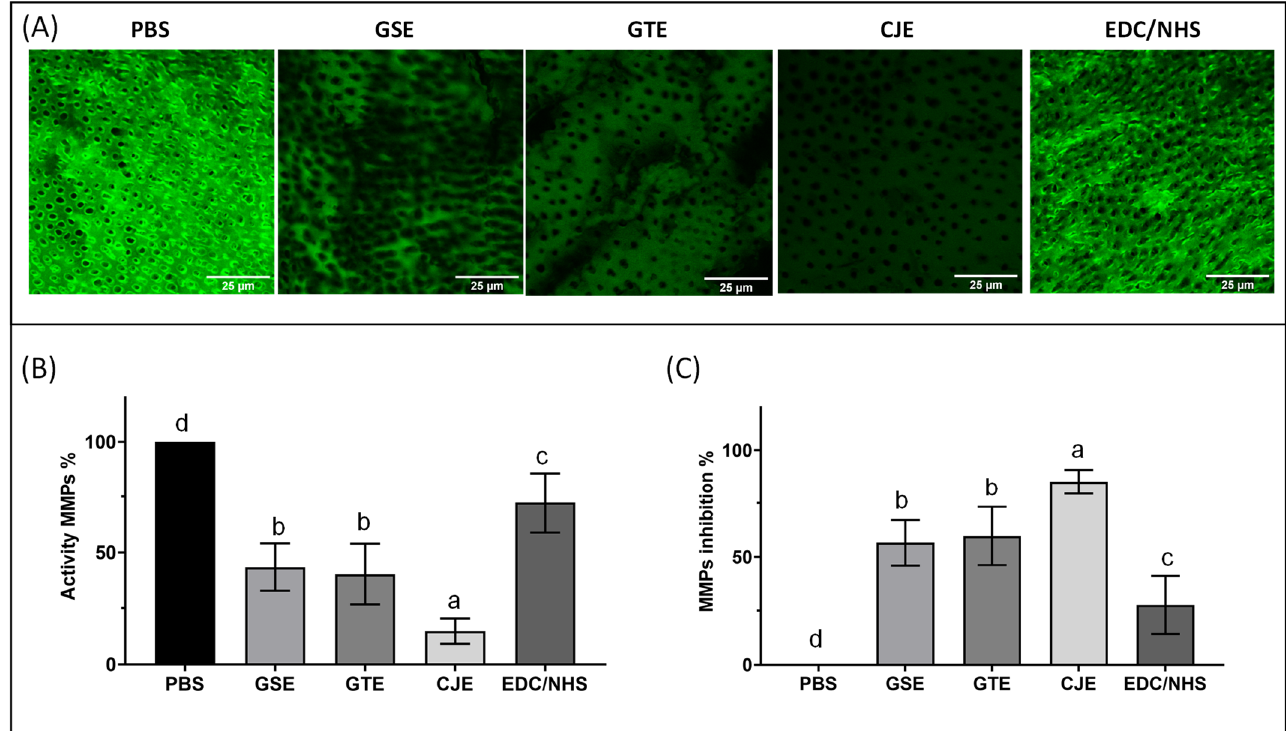
Figure 5. Representative in situ zymogram confocal laser scanning microscopic (CLSM) images acquired in the green channel showing the fluorescence attributed to the MMP activity in the dentin collagen films for all experimental groups after 24 h of incubation in the quenched fluorescein-labeled gelatin ( A ). The graphs show the quantitative MMP activity ( B ) and MMP inhibition ( C ) for all groups. Means with different letters are significantly different ( p < 0.05). PBS: phosphate buffered saline. GSE: grape seed extract. GTE: green tea extract. CJE: cranberry juice extract. EDC/NHS: carbodiimide/n-hydroxysuccinimide.